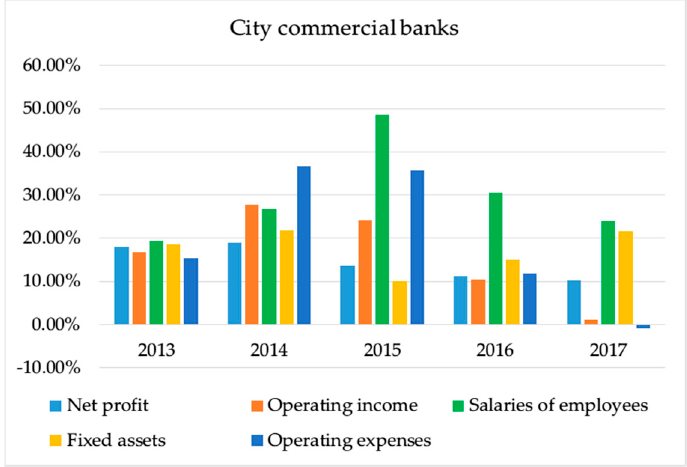
Figure 4. The trends of inputs and outputs (2012–2017).